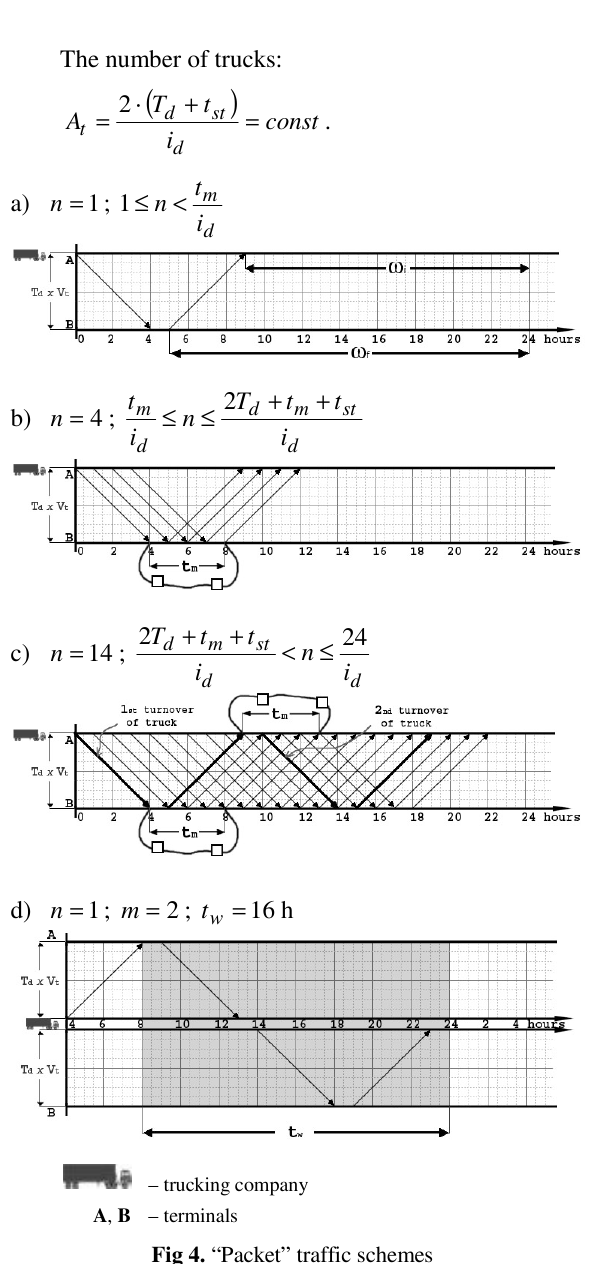
Fig 4. “Packet” traffic